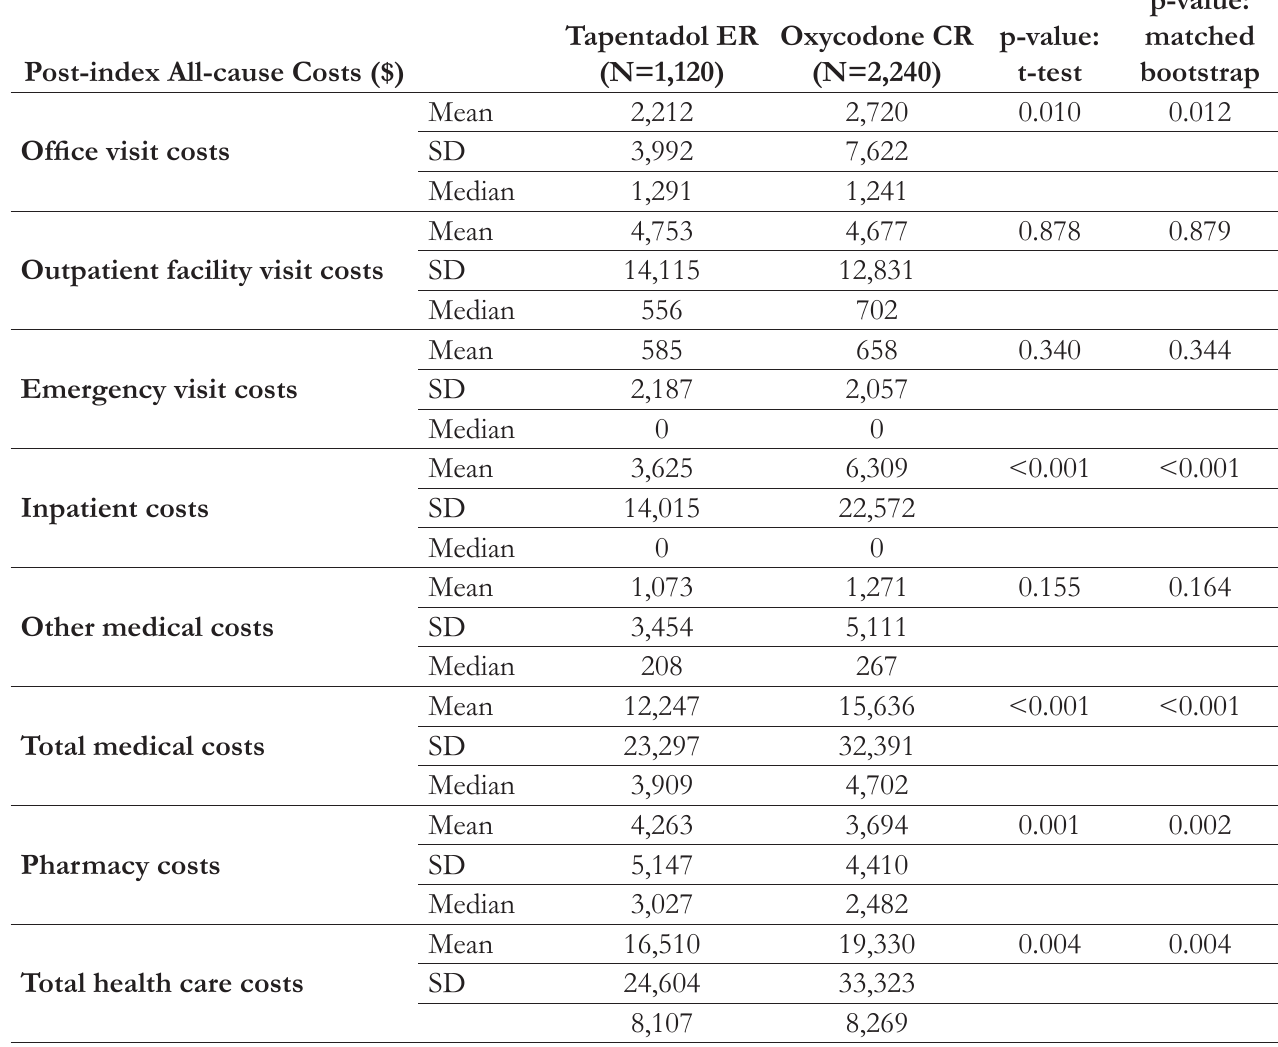
Table 4. Post-index Health Care